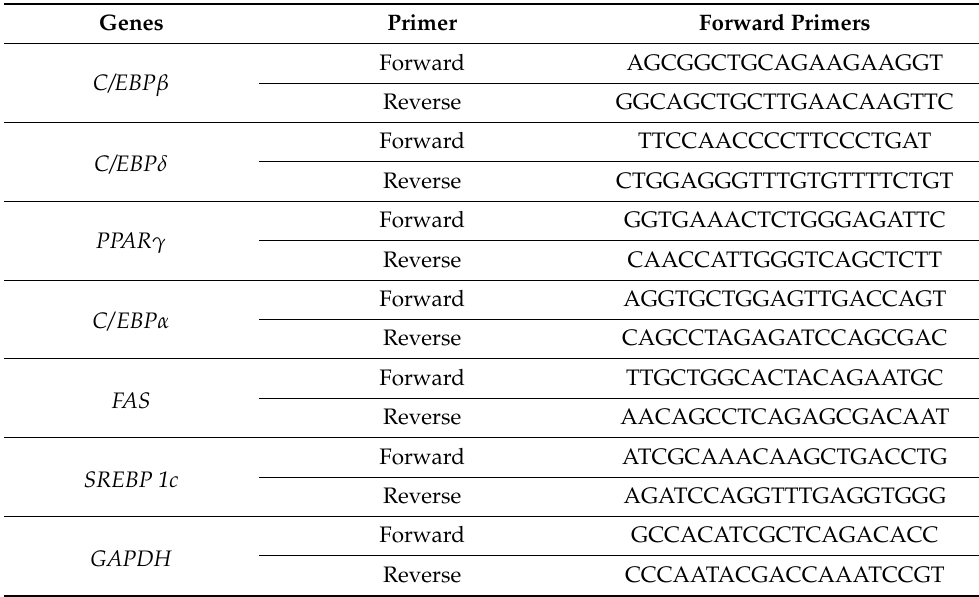
Table 1. Sequences of real-time PCR